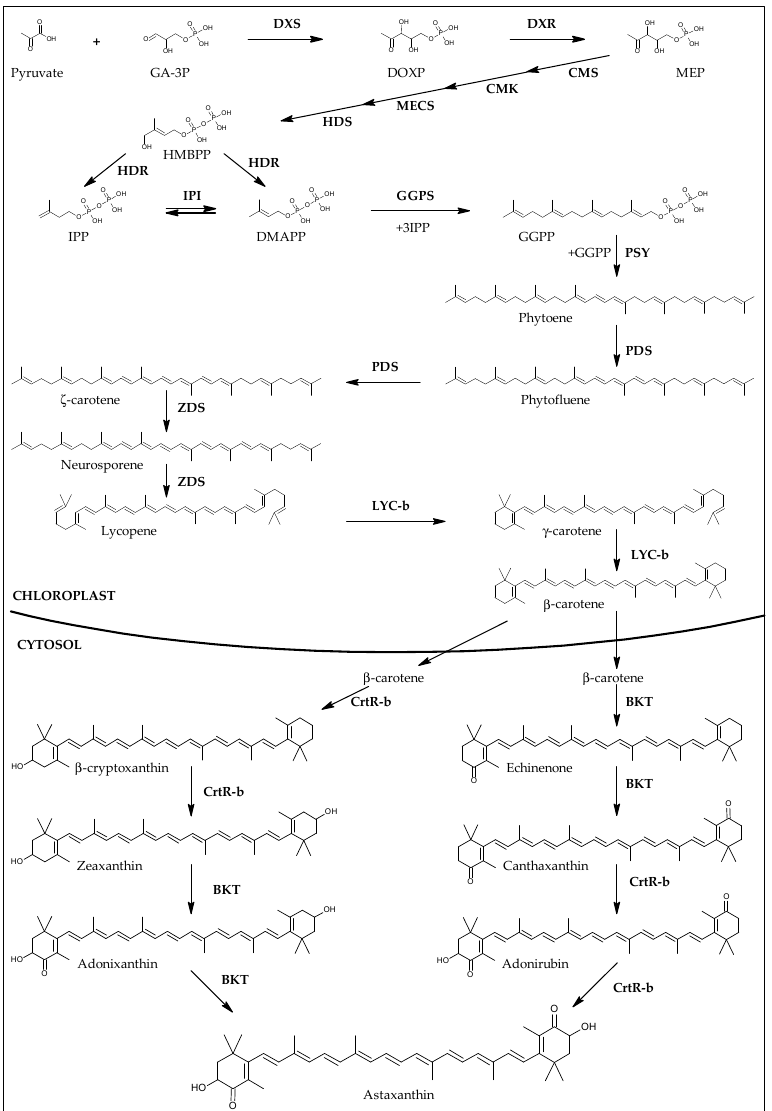
Figure 5. Overall pathway for astaxanthin biosynthesis in H. pluvialis [5,148,149]. Abbreviations: GA-3P, D-glyceraldehyde-3-phosphate; DXS, 1-deoxy-D-xylulose-5-phosphate synthase; DOXP, 1-deoxy-D-xylulose-5-phosphate; DXR, 1-deoxy-D-xylulose-5-phosphate reducto-isomerase; MEP, 2-C-methyl-D-erythritol-4-phosphate; CMS, 4-diphosphocytidyl-2-C-methyl-D-erythritol synthase; CMK, 4-diphosphocytidyl-2-C-methyl-D-erythritol kinase; MECS, 2-C-methyl-D-erythritol 2,4-cyclodiphosphate synthase; HDS, 1-hydroxy-2-methyl-2-butenyl 4-diphosphate synthase; HMBPP; 1-hydroxyl-2-methyl-2-butenyl-4-diphosphate; HDR, 1-hydroxy-2-methyl-2-butenyl 4-diphosphate reductase; IPP, isopentenyl pyrophosphate; IPI, isopentenyl pyrophosphate isomerase; DMAPP, dimethylallyl pyrophosphate; GGPS, geranylgeranyl pyrophosphate synthase; GGPP, geranylgeranyl pyrophosphate; PSY, phytoene synthase; PDS, phytoene desaturase; ZDS, ζ -carotene desaturase; LYC-b, lycopene β -cyclase; BKT, β -carotene ketolase; CrtR-b, β -carotene